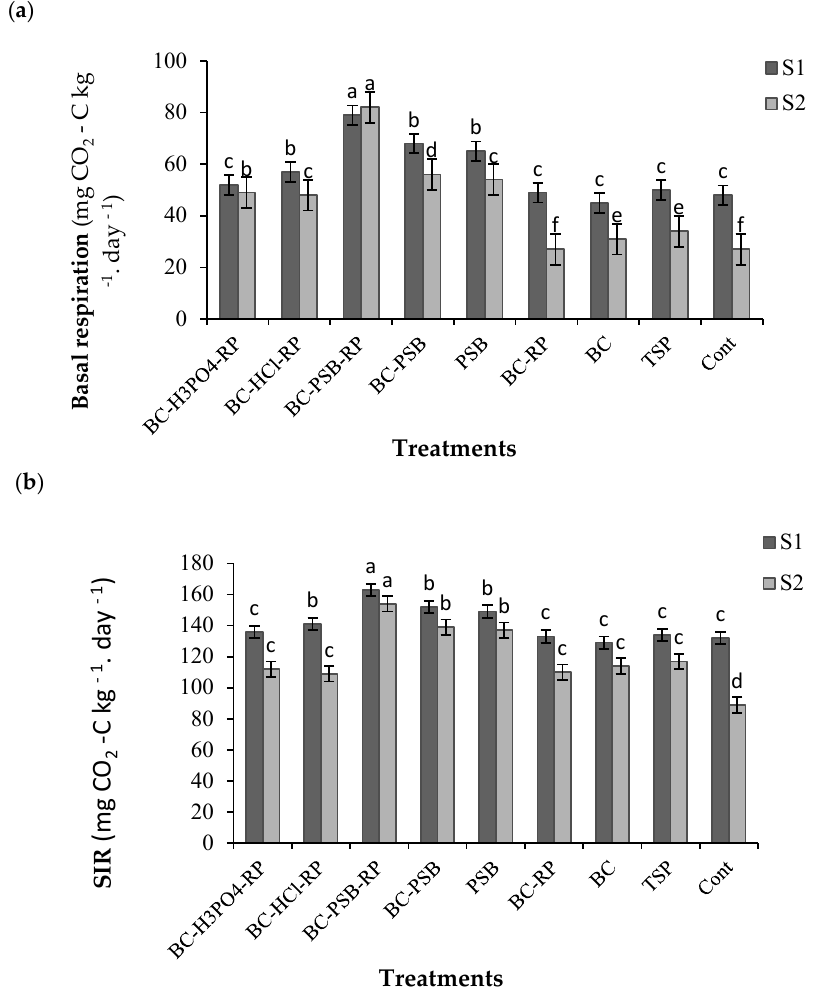
Figure 6. Effect of different treatments on soil respiration indices. ( a ): Basal respiration; ( b ): Substrate- Induced Respiration. PSB: phosphate solubilizing bacteria, BC: biochar, BC-PSB: biochar with phosphate solubilizing bacteria, BC-PSB-RP: biochar enriched with PSB and RP, BC-HCl-PSB: biochar enriched with HCl -RP, BC-H 3 PO 4 -RP: biochar enriched with H 3 PO 4 -RP, TSP: triple super phosphate, Cont: control. Means with similar letters are not significantly different at 1% probability level according to LSD test. Error bars are standard deviation of the means ( n = 3), S1 and S2: soil 1 with EC = 2 dS.m − 1 and soil 2 with EC = 15 dS.m − 1 , respectively.